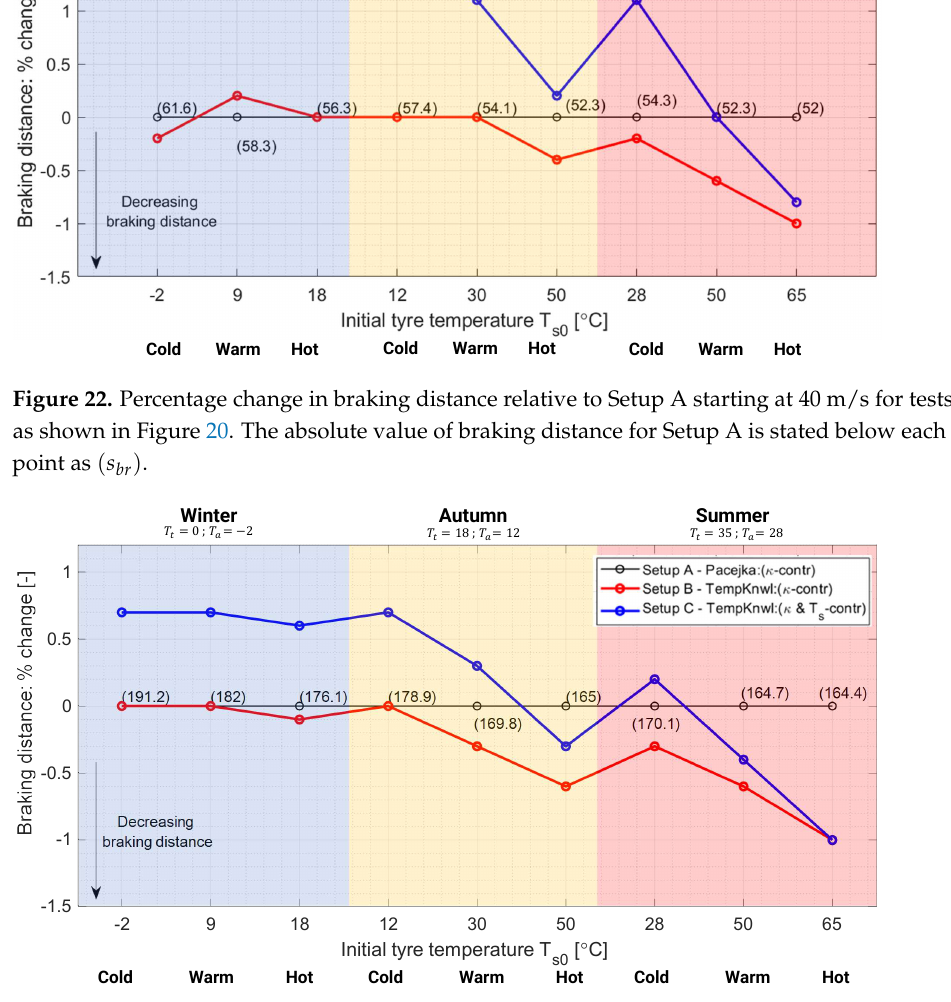
Figure 23. Percentage change in braking distance relative to Setup A starting at 70 m/s for tests 10–18, as shown in Figure 20. The absolute value of braking distance for Setup A is stated below each data point as ( s br )